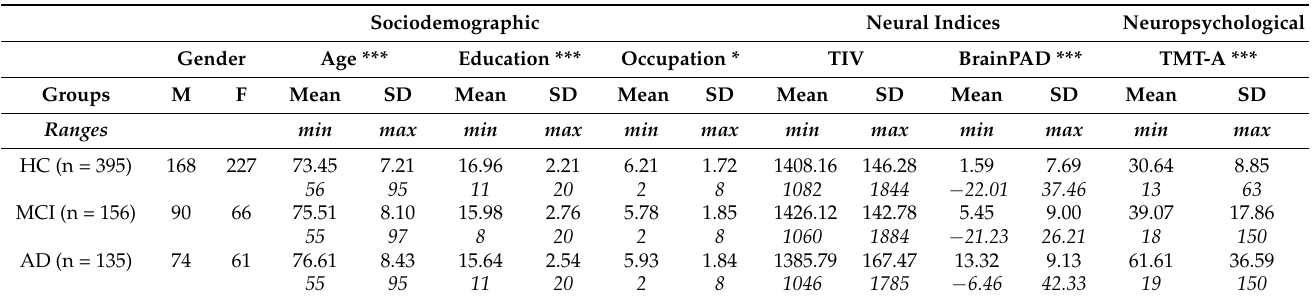
Table 1. Sociodemographic, neural indices and neuropsychological characteristics of the HC, MCI and AD groups. Key: TIV, total intracranial volume; BrainPAD, Brain predicted age discrepancy (biological maintenance index); TMT-A. trail making test part A time in seconds. (* p < 0.05; *** p < 0.001 Bonferroni correction). Neural Indices